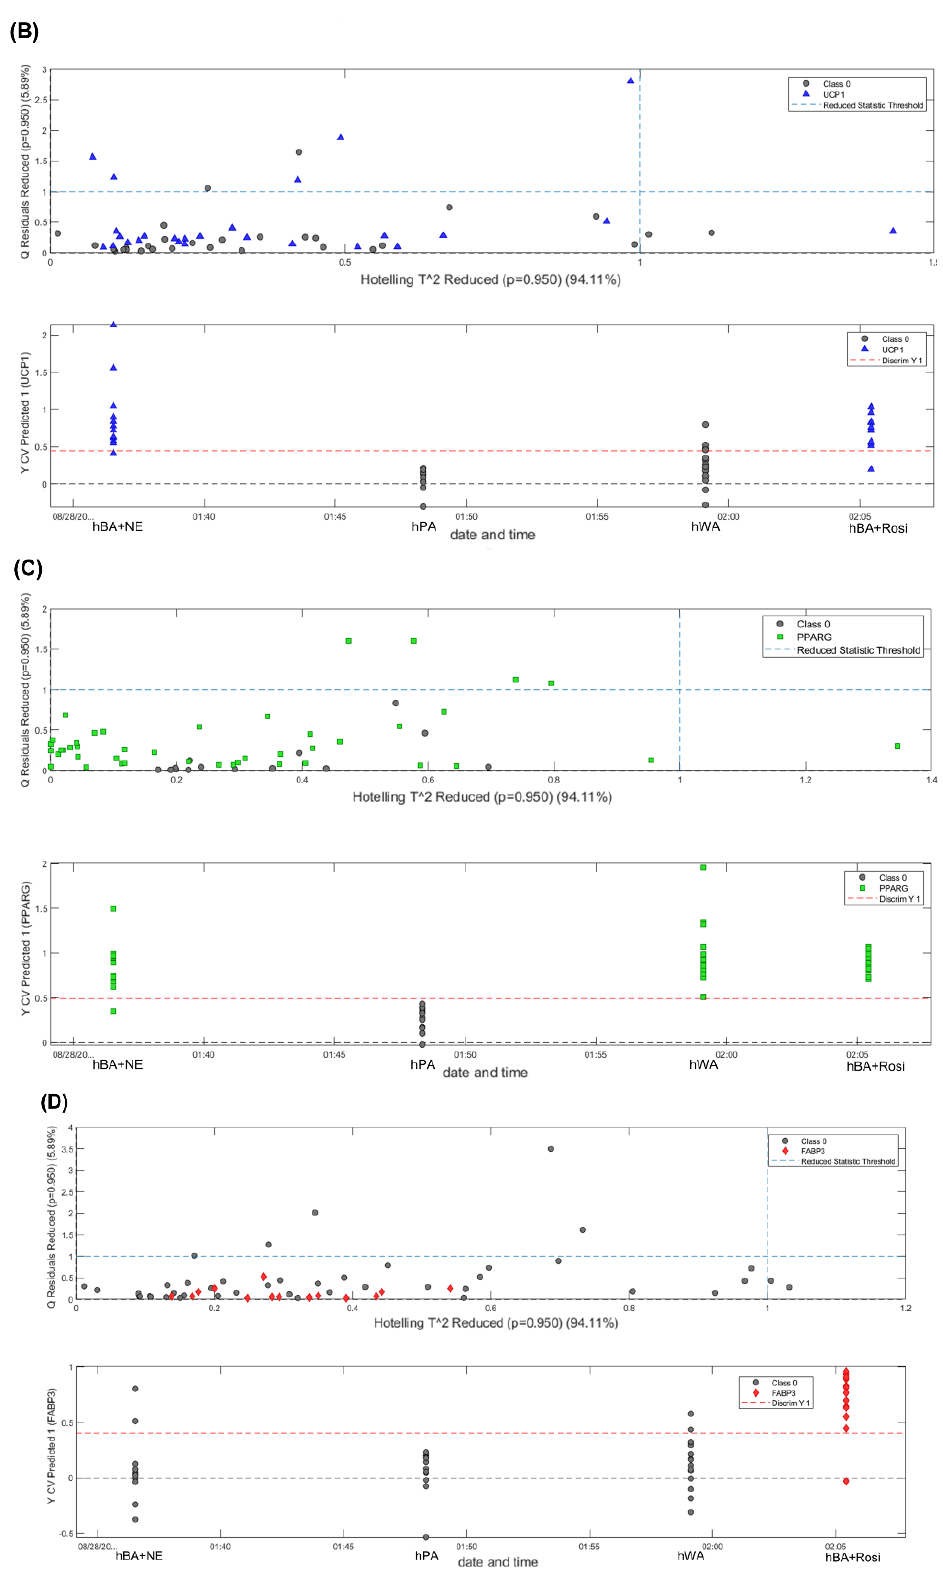
Figure 5. Classification of adipocytes and expression distribution of adipogenic genes in adipocytes determined using PLS-DA. ( A ) Classification of adipocytes using PLS-DA. ( B ) UCP1 (cid:48) s expression dis- tribution using PLS-DA. ( C ) PPARG’s expression distribution using PLS-DA. ( D ) FABP3 (cid:48) s expression distribution using